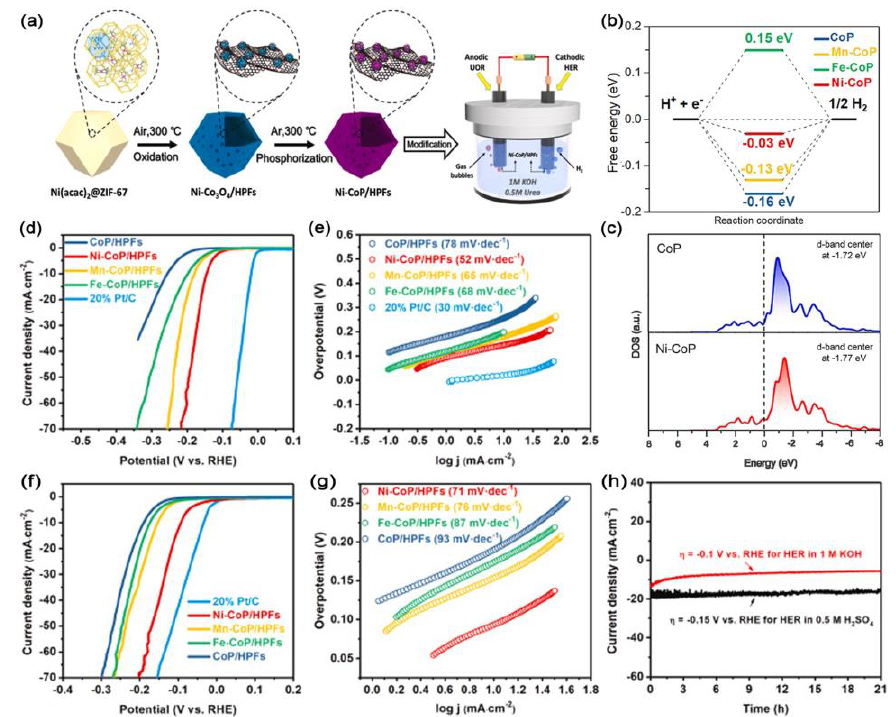
Figure 9. ( a ) Synthesis scheme of the Ni-CoP/HPFs. ( b ) The calculated free-energy diagram of Ni − CoP, Mn − CoP, Fe − CoP, and CoP. ( c ) Calculated DOS curves for CoP and Ni − CoP. ( d , f ) LSV curves, ( e , g ) Tafel plots in 0.5 M H 2 SO 4 and 1 M KOH, respectively. ( h ) Time-dependent of current density curves over Ni − CoP/HPFs catalyst during electrolysis at − 0.15 V vs. RHE in 0.5 M H 2 SO 4 and − 0.1 V vs. RHE in 1 M KOH [109]. Copyright 2019, Elsevier B.V.